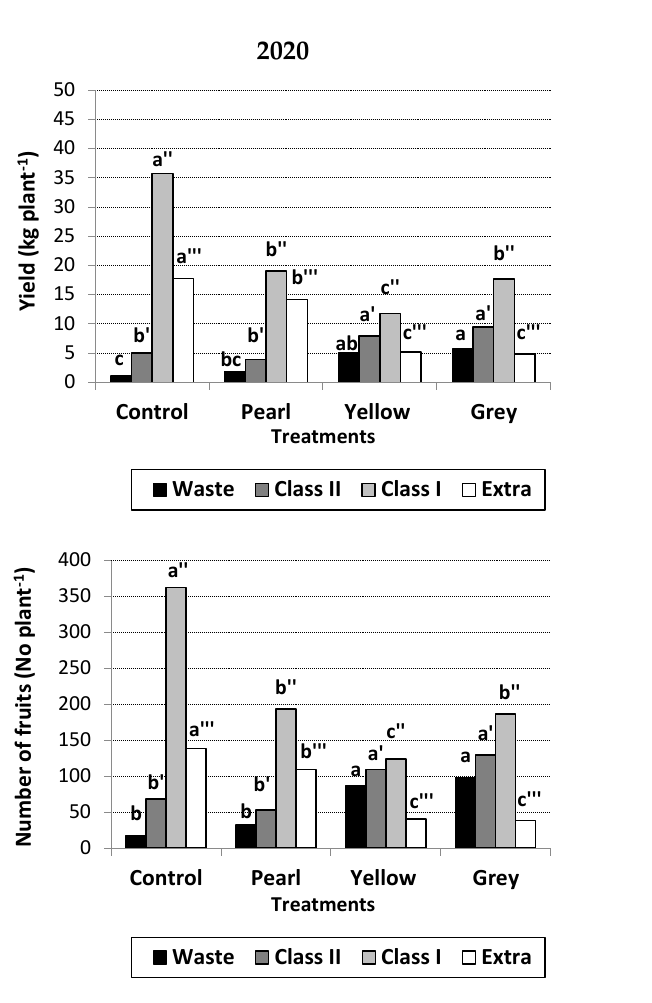
Figure 3. Kiwifruit yield (kg plant − 1 ) and number of fruits (No plant − 1 ) for each grade (Waste, Class II, Class I, Extra) for uncovered plants (control) and plants under the three photo-selective nets (pearl, yellow and grey), in 2020 and 2021. For each year and each grade, bars with different letters are significantly different ( p < 0.05).